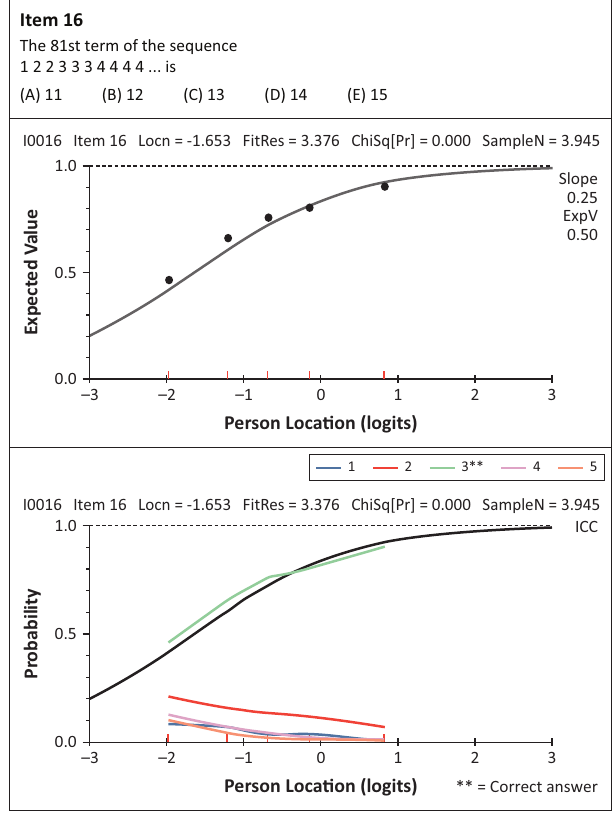
FIGURE 5: Item 16, with item characteristic curve, and multiple choice distractor